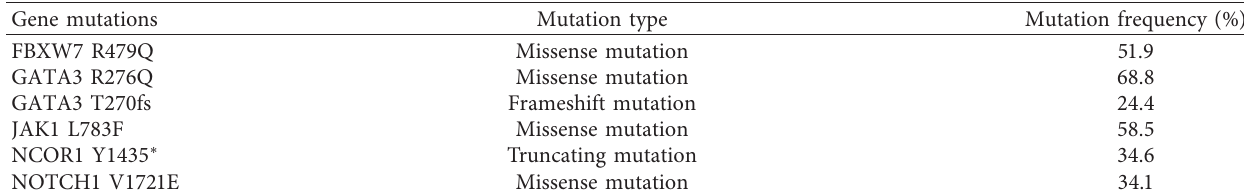
Table 2: Results of RNA